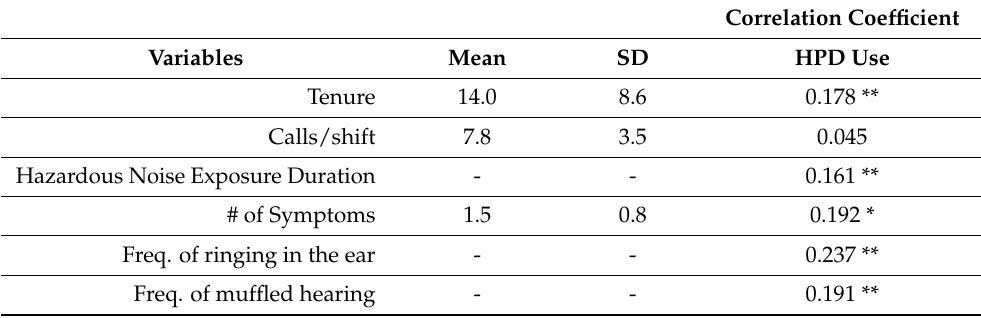
Table 2. Descriptive statistics and correlation coefficients for survey variables.